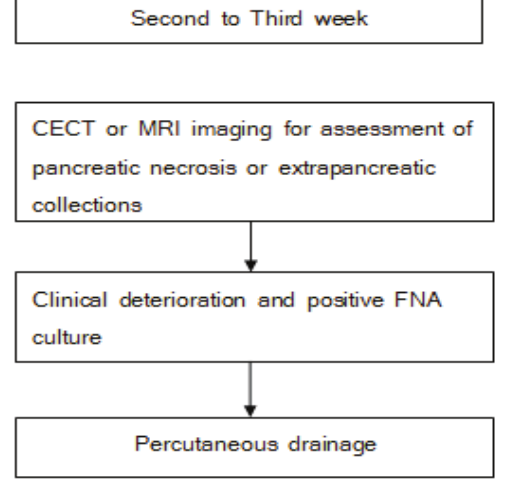
Figure 1: Algorithm showing a step-up approach for second to the third week